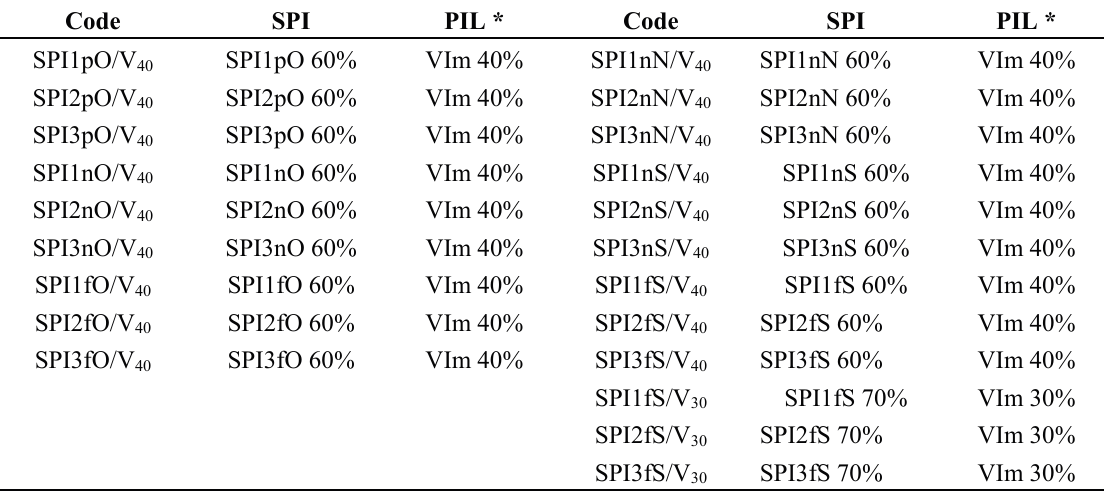
Table 2. Codes and weight compositions of sulfonated polyimide/protic ionic liquid (SPI/PIL) composite